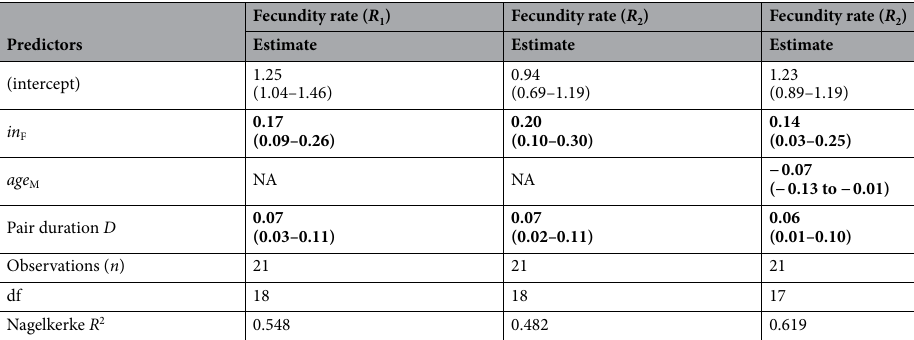
Table 4. Summary of the most parsimonious model for two measures of fecundity rate. Parameter estimates given as mean with 95% CI in the parentheses. Parameters significantly different from zero (95% CI does not overlap zero) highlighted in bold. Degrees of freedom (df) for the LMMs approximated by the Kenward–Roger method. in = Inquisitiveness, age = initial age at pair formation, F = female, M = male, NA = parameter not included as explanatory for the given response.